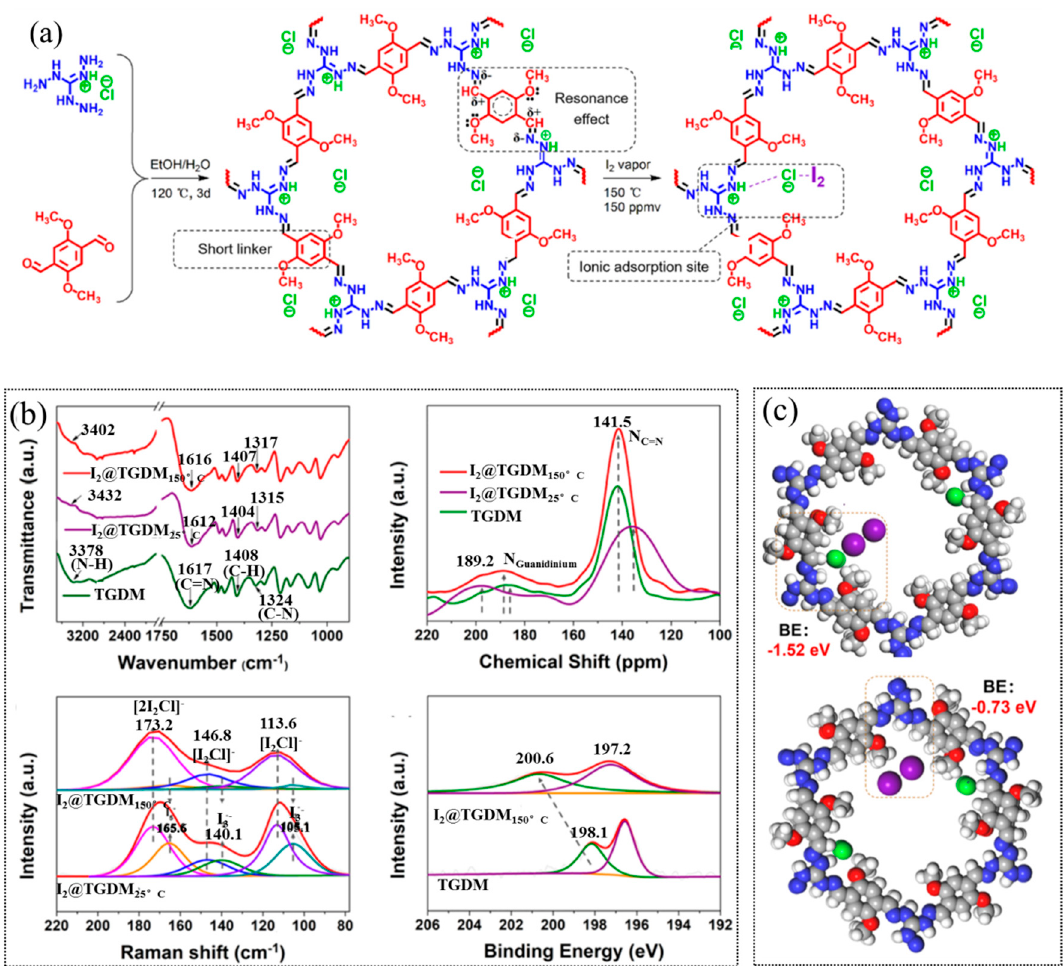
Figure 14. ( a ) Schematic illustration of the design and synthesis of TGDM and explanation of its high stability and I 2 uptake mechanism. ( b ) FT-IR spectra, solid-state 15 N NMR spectra, Raman spectra, and XPS Cl 2p spectra of TGDM and iodine-loaded samples. ( c ) Two typical configurations of I 2 interacting with the guanidinium group in TGDM and the corresponding calculated binding energies. Reprinted/adapted with permission from Ref. [74]. Copyright (2022), American Chemical Society.